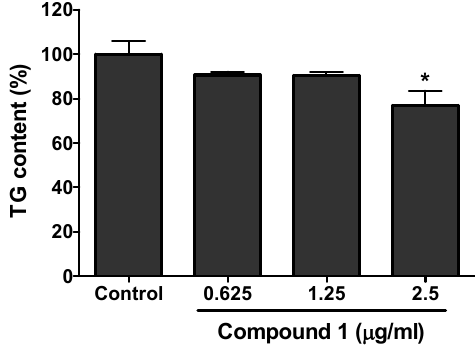
Figure 6. Total triacylglycerol (TG) content in the 3T3-L1 cells with or without the treatment of compound 1 . Cells were cultured and seeded in 6-well plated. Cells were di ff erentiated using di ff erentiation media in presence or absence of compound 1 . The cells were lysed and TG content was evaluated using the kit. The significant inhibition of TG content compared to the control was seen in the highest concentration used in the analysis. The data show relative mean TG content percentage ± SD of triplicate experiments. Statistical significance was calculated using one-way ANOVA followed by Dunnett’s test. * P < 0.05 vs.